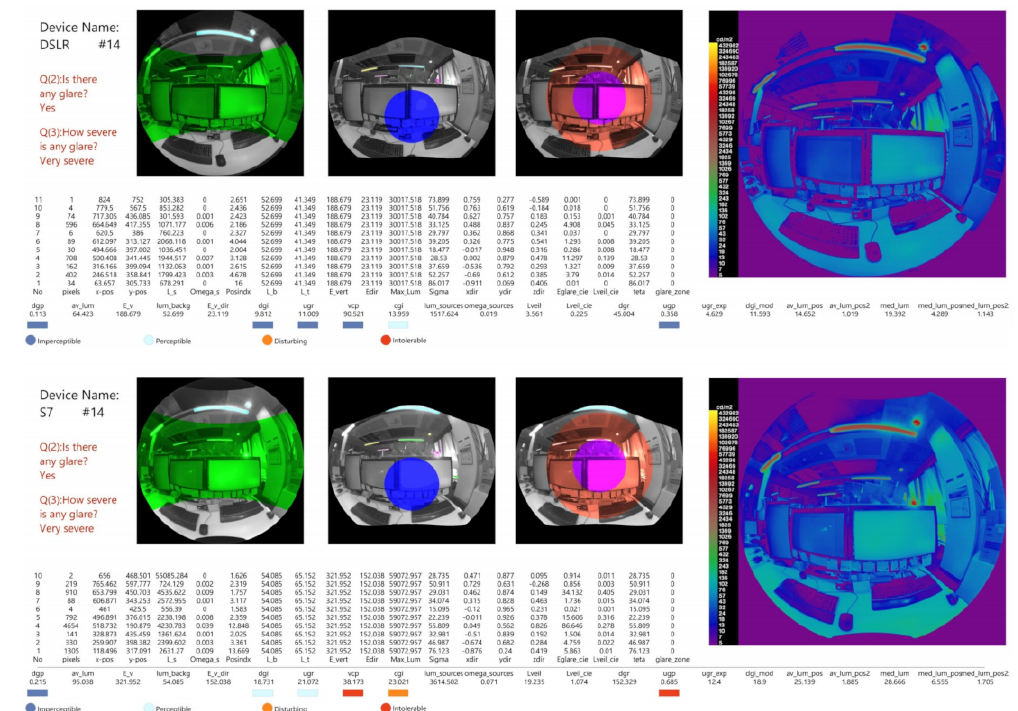
Figure 20. The random errors found in almost identical FOV with very small variation (the sun was shaded by the monitor on the DSLR photo; however it was visible in the Samsung S7 photo), which resulted in significant variation in the calculation of glare indices (e.g., UGP was 0.368 in DSLR and 0.685 in Samsung